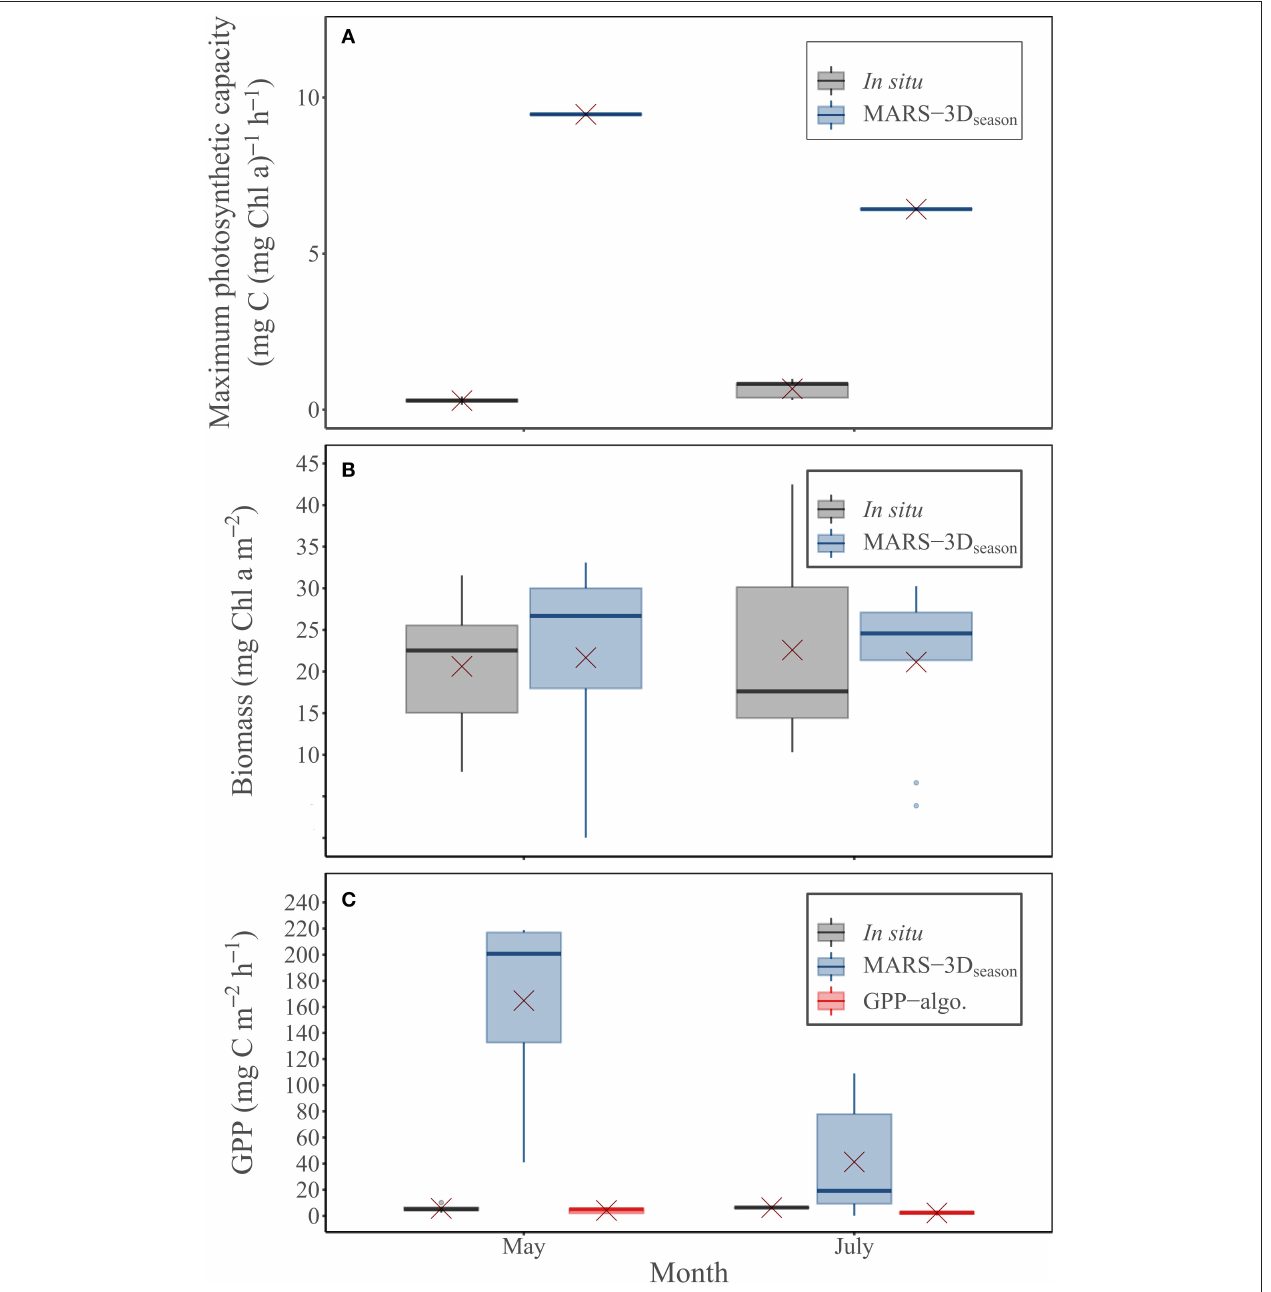
FIGURE 7 | Measured and simulated (MARS-3D season run) (A) maximum photosynthetic capacity ( P b MAX , mg C (mg Chl a ) − 1 h − 1 ) and (B) MPB biomass in the biofilm (mg Chl a m − 2 ) during in situ sampling days in May and July 2015. (C) MPB GPP (mg C m − 2 h − 1 ) measured and predicted by the MARS-3D season run and the GPP-algo during in situ sampling days in May and July 2015. Red crosses correspond the mean value of PAR and MST for the corresponding period.